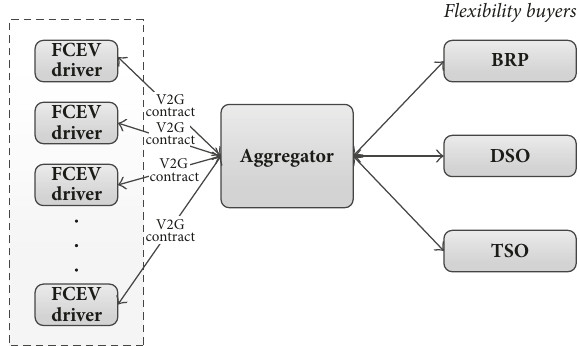
Figure 1: Relationships of actors in the V2G value chain, based on